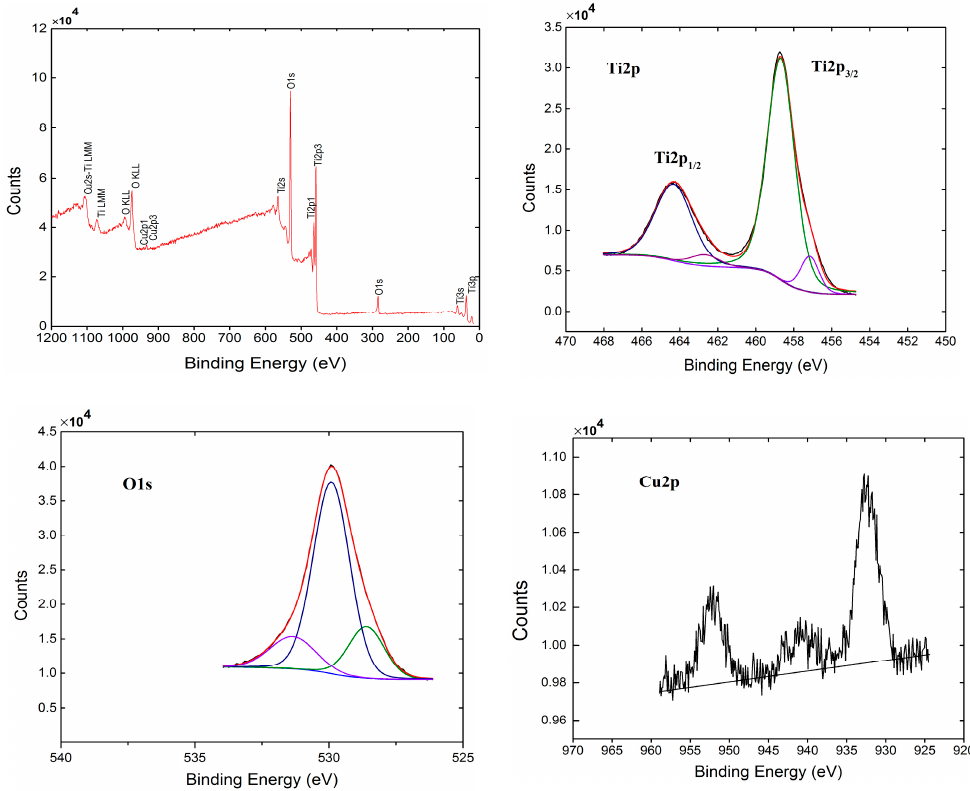
Figure 7. X ‐ ray photoelectron spectroscopy (XPS) spectra of CuTiO 2 NTs labelled Cu ‐ 01. Figure 7. X-ray photoelectron spectroscopy (XPS) spectra of CuTiO 2 NTs labelled Cu-01.